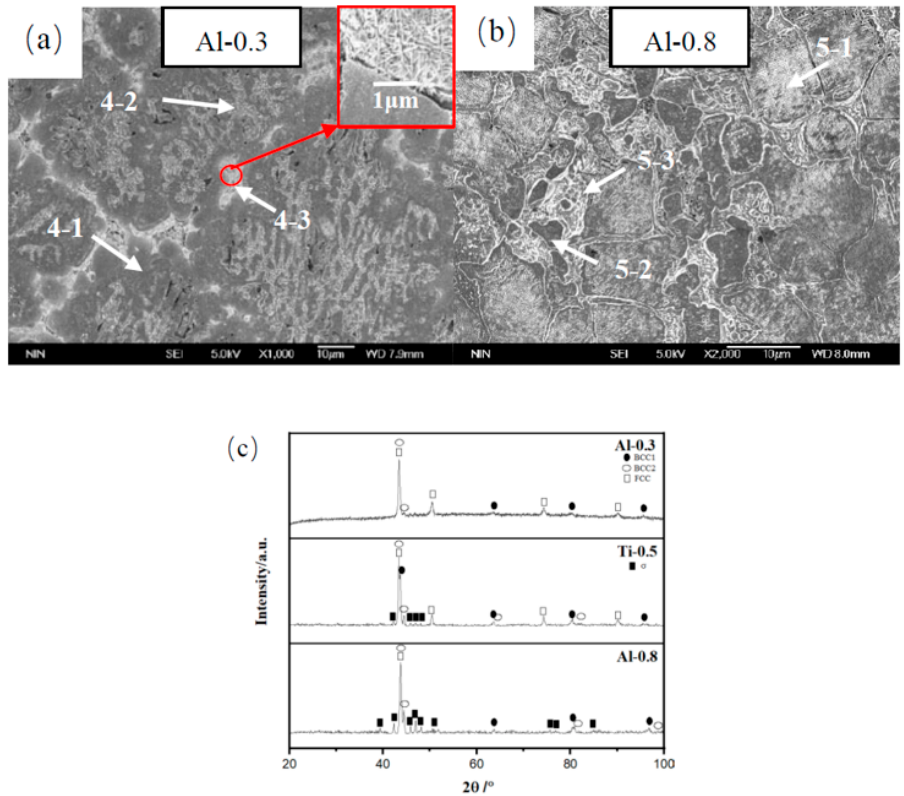
Figure 3. Microstructure and XRD results for Al x CoCrFeNiTi0.5 HEAs: ( a ) Al-0.3 alloy, ( b ) Al-0.8 alloy; and ( c ) XRD results.